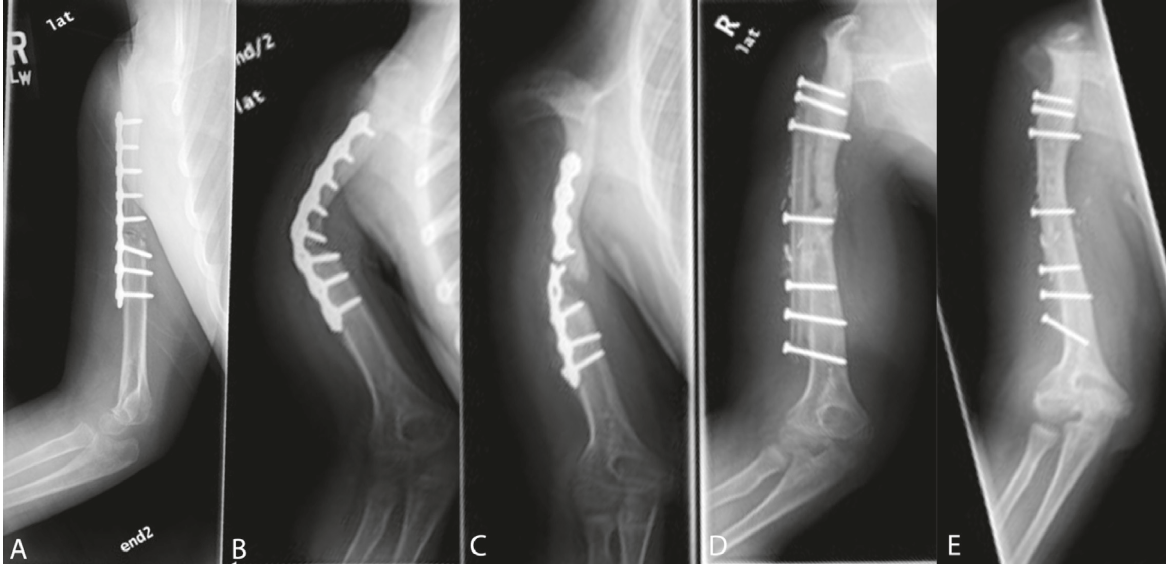
Figure 1: (a) 3 months after primary limb reconstruction with clavicula pro humero (CPH) procedure. (b) Nonunion at 9 months after original CPH procedure. (c) Subsequent fracture at 19 months after original CPH. (d) Secondary salvage procedure 24 months after CPH with onlay free vascularized fibular flap. (e) Union and remodeling of fibular flap 63 months after original CPH